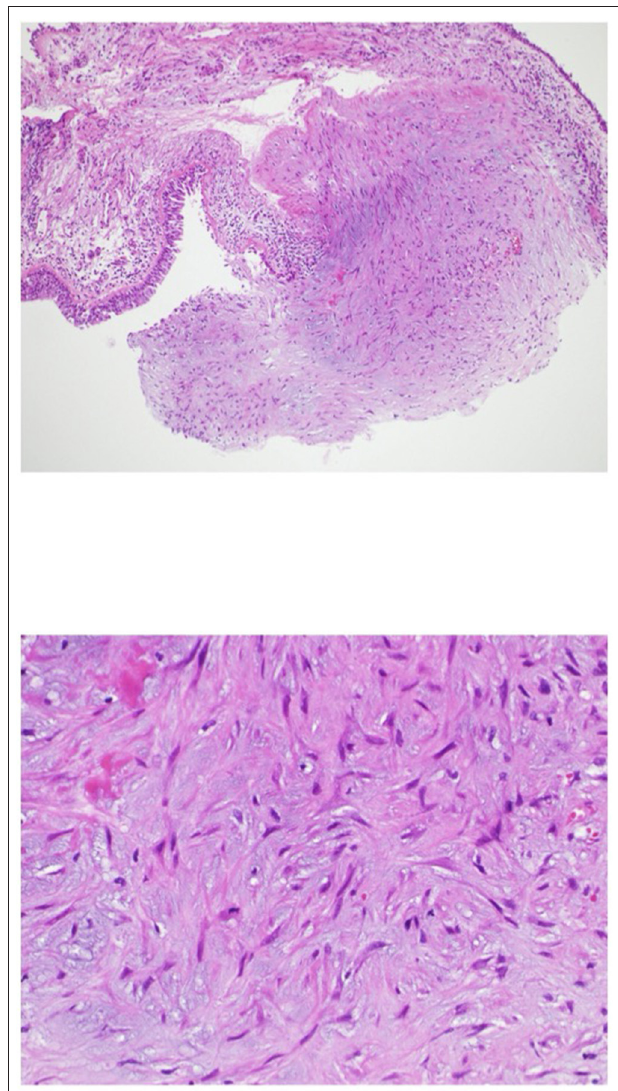
FIGURE 3 | Findings in biopsy specimen from the hemorrhagic polypoid lesion. The upper panel shows a weakly magnified image of HE staining, and the lower panel shows a strongly magnified image of HE staining. Foci of reactive myofibroblast proliferation were observed from the bronchial mucosa to the bronchial